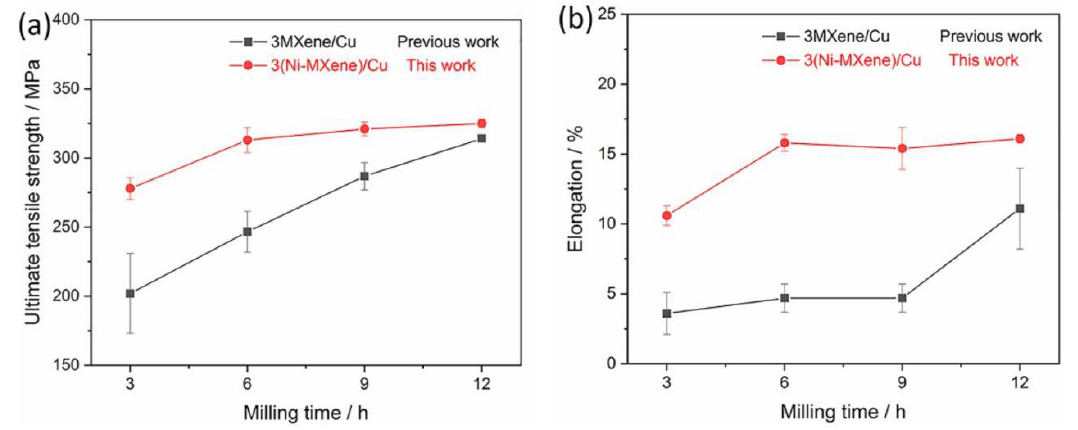
Figure 34. The UTS and elongation of 3(Ni-MXene)/Cu composites: ( a ) the variation of UTS with the milling time; ( b ) the variation of elongation with the milling time [75].